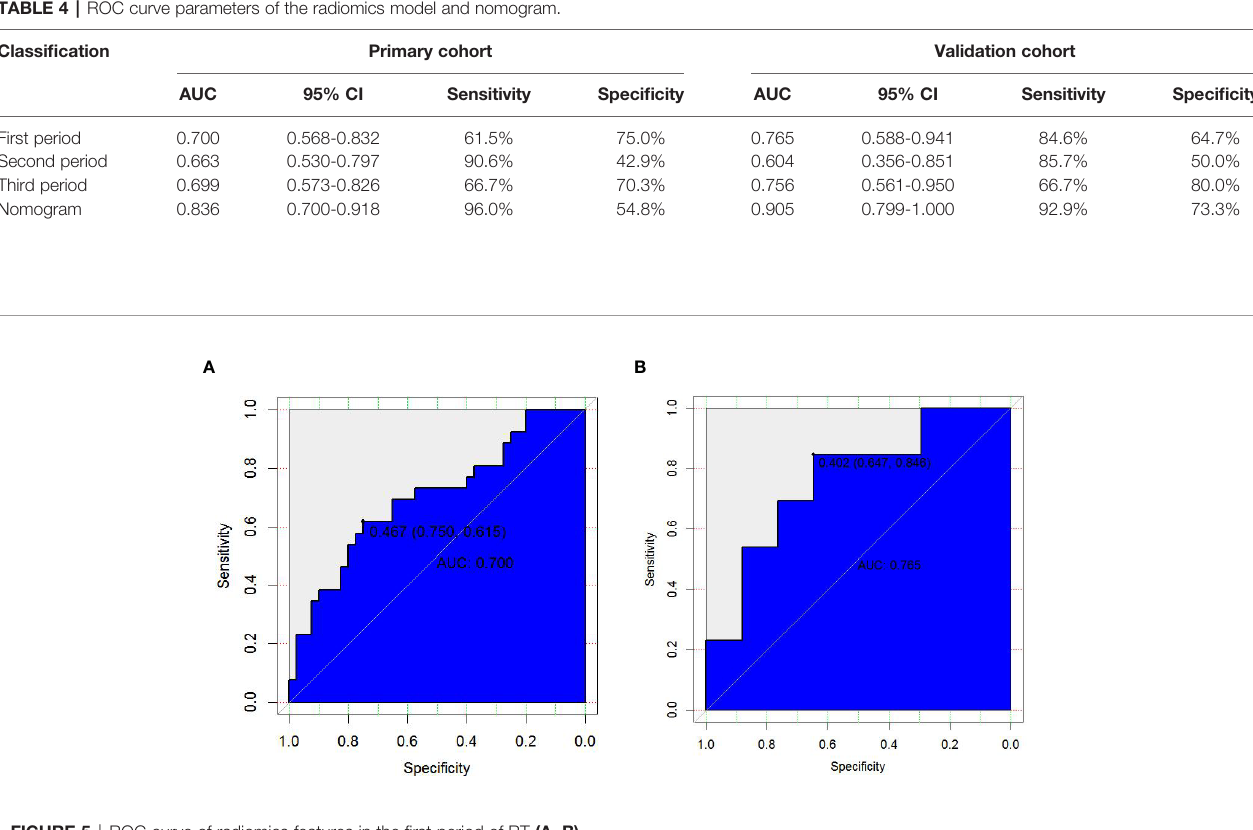
FIGURE 5 | ROC curve of radiomics features in the fi rst period of RT (A, B)